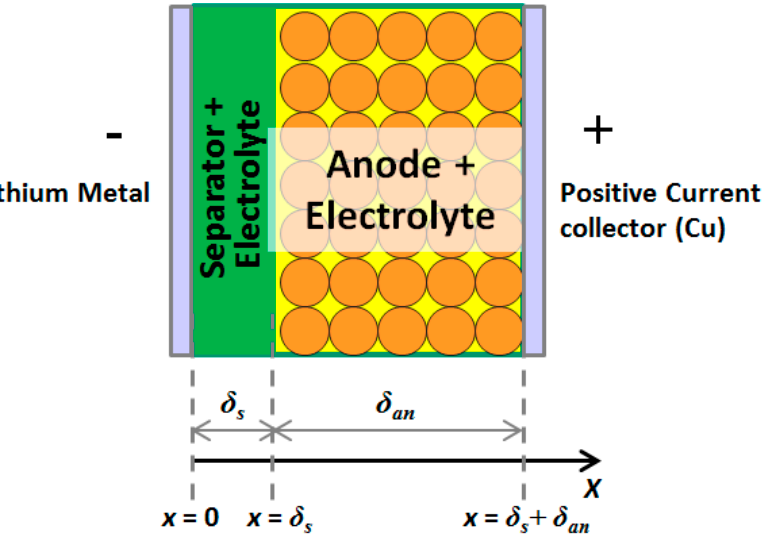
Figure 8. Geometry setup for a half-cell model with a graphite or LTO anode (single particle schematics).